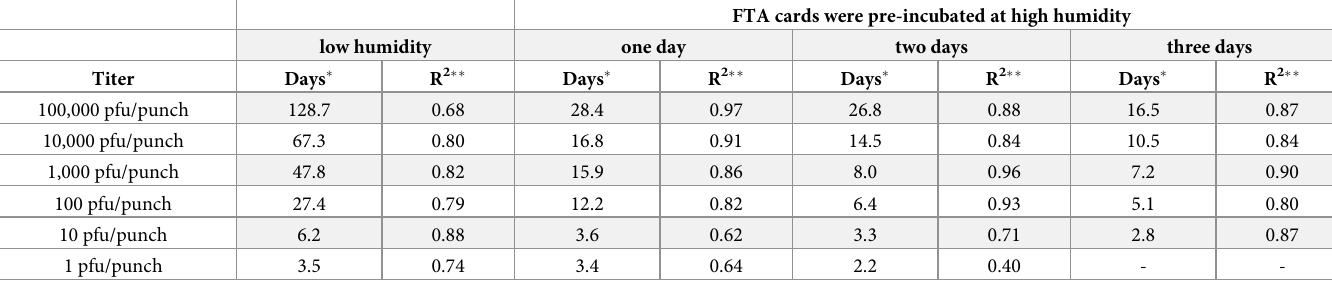
Desiccating FTA cards prior to inoculation improves YFV RNA stability In an attempt to reduce the loss of RNA yield at high humidity, pre-humidified cards were incubated with desiccation packets for one, two and seven days prior to inoculation with low titer YFV (illustrated in S3 Fig). The addition of desiccation packets resulted in an extended detection time compared to the same concentration/punch incubated with no desiccation (Table 3). For punches inoculated with 10 pfu/punch, two desiccation packets significantly extended the length of detection after one day of desiccation (95% CI: 0.1, 1.1) compared to one packet. For punches inoculated with 1 pfu/punch, there was not a significant change in the length of detection between cards pre-incubated for one or two days with one or two desiccant Table 2. Storage of FTA cards in humid environments negatively impacts the ability of the cards to stabilize YFV RNA over time. FTA cards were pre-incubated at high